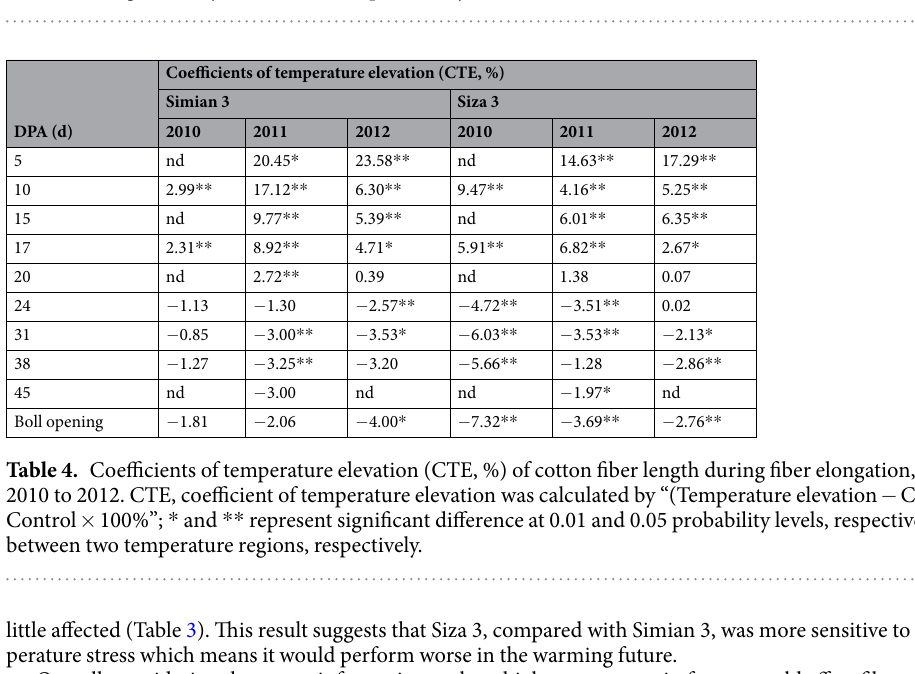
Table 3. Eigen-values of cotton fiber elongation with cotton cultivars of Simian 3 and Siza 3 under the elevated and ambient temperature regimes from 2010 to 2012. FRED, fiber rapid − elongation duration; V max , the maximum fiber elongation rate; 95% Conf., 95% confidence interval; Len m , theoretical maximum fiber length; Len obs , observed fiber length; CTE, Coefficient of temperature elevation; CV, Coefficient of variation; ** significant difference at 0.05 probability level (n = 6, R 2 0.05 = 0.6584, R 2 0.01 = 0.8413; n = 9, R 2 0.05 = 0.4440, R 2 0.01 = 0.6354; n = 10, R 2 0.05 = 0.3994, R 2 0.01 = 0.5885). Values followed by a different letter within the same column are significantly different at 0.05 probability levels.